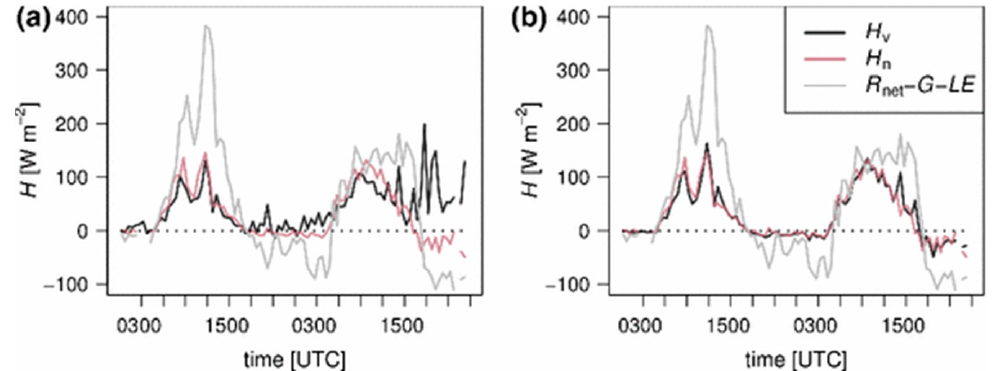
Figure 4. Daily cycle of sensible heat flux, H, at 2-m height when a mobile tower with two sonic anemometers was operated on a slope: one installed vertically (H v ) and one slope-normal (H n ). Data are from two consecutive days with weak synoptic forcing (‘purely’ thermally driven valley and slope wind regime). ( a ) Values of heat flux from both sonic orientations, rotated only into the mean wind. Coordinate rotation for w was only applied to slope-normal orientation. ( b ) Values of heat flux from both installations, after double rotation was applied to both. The remaining terms of the energy balance closure (net radiation R net minus ground heat flux, G, and latent heat flux, LE) are also plotted as a reference (from [85], Copyright: Open Access, CC-BY).